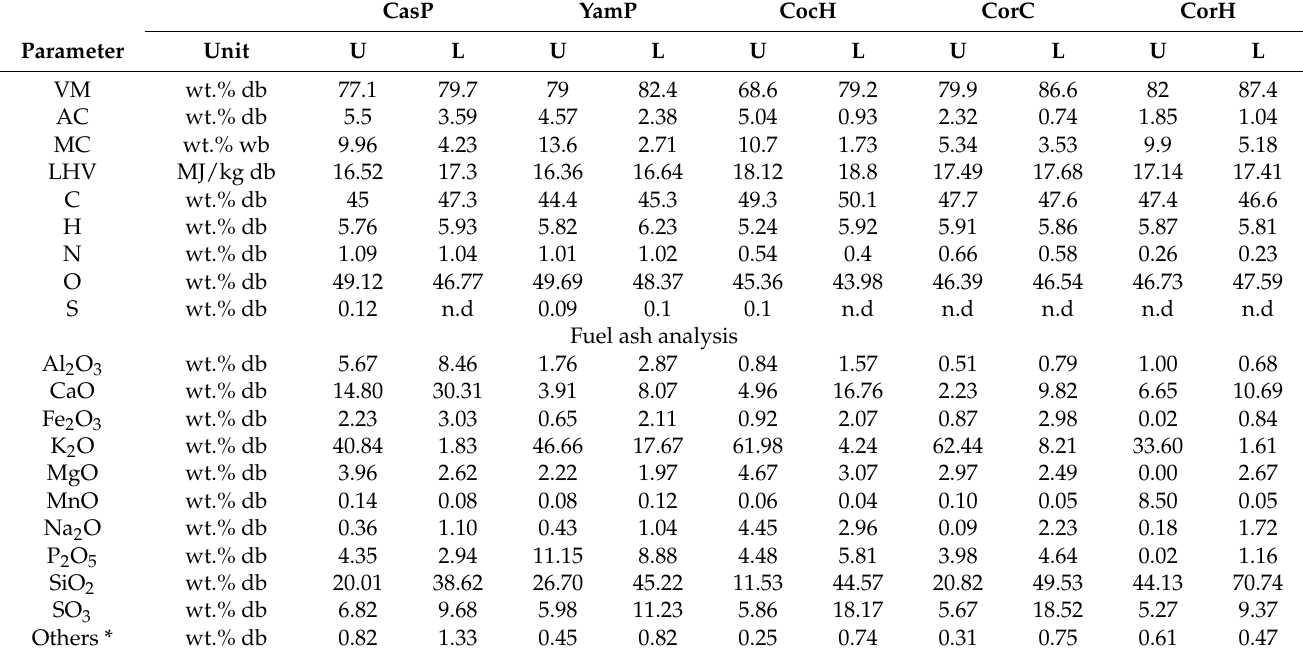
Table 2. Fuel and fuel ash properties of untreated (U) and acid leached (L), cassava (CasP), yam (YamP), coconut (CocH), corncob (CorC) and corn husk (CorH). Inorganic species are specified on fuel ash basis. Abbreviations wb, db, and n.d. stand for wet basis, dry basis and not detected. Oxygen is calculated by difference. VM: volatile matter; AC: ash content; MC: moisture content; and LHV: lower heating